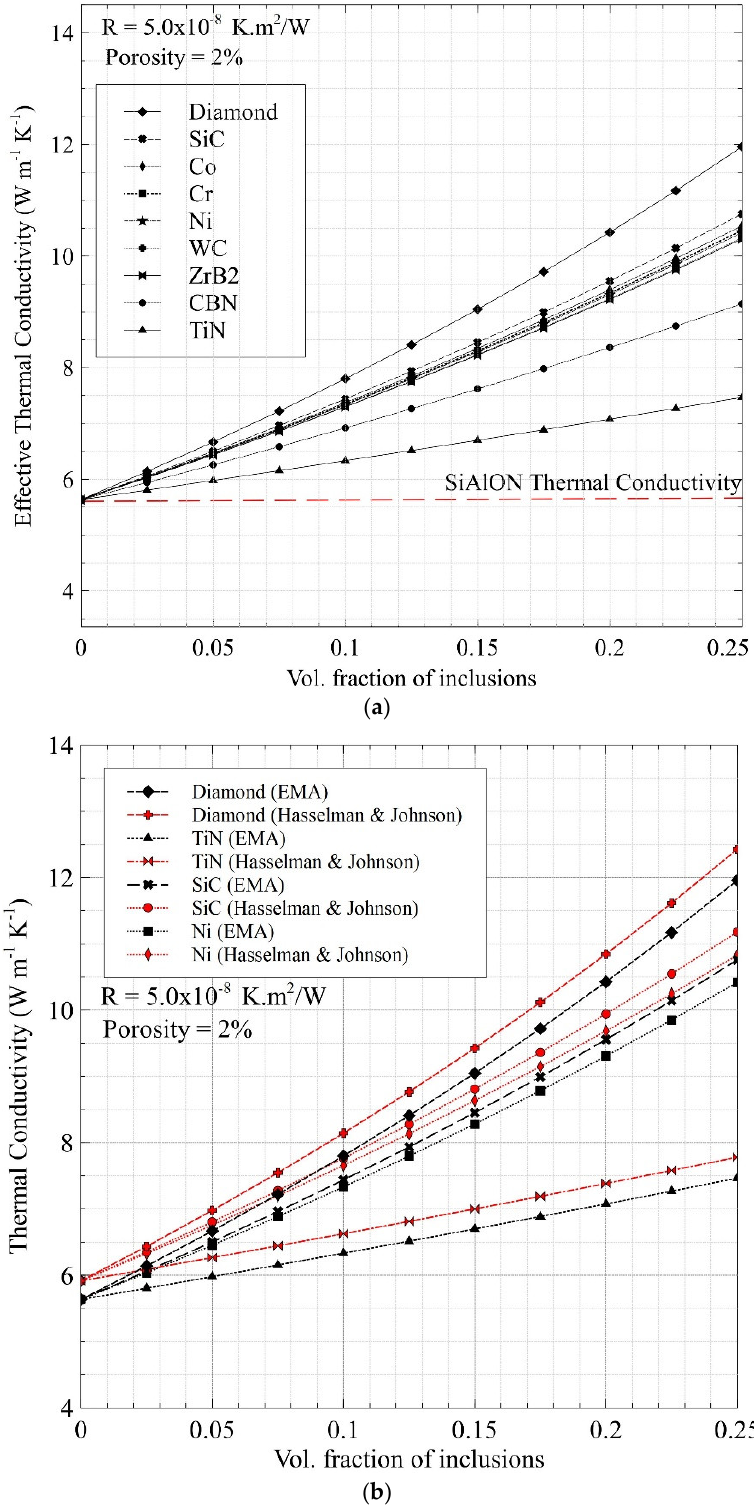
Figure 2. ( a ) Predicted effective thermal conductivity of Ca-α-SiAlON composites as a function of volume content of potential metal and ceramic reinforcements. ( b ) Comparison of predictions made with the modified EMT and Hasselman–Johnson models. The porosity is assumed to be 2% and the thermal interface resistance ( R ) is taken as 5.0 × 10 −8 K.m 2 /W.